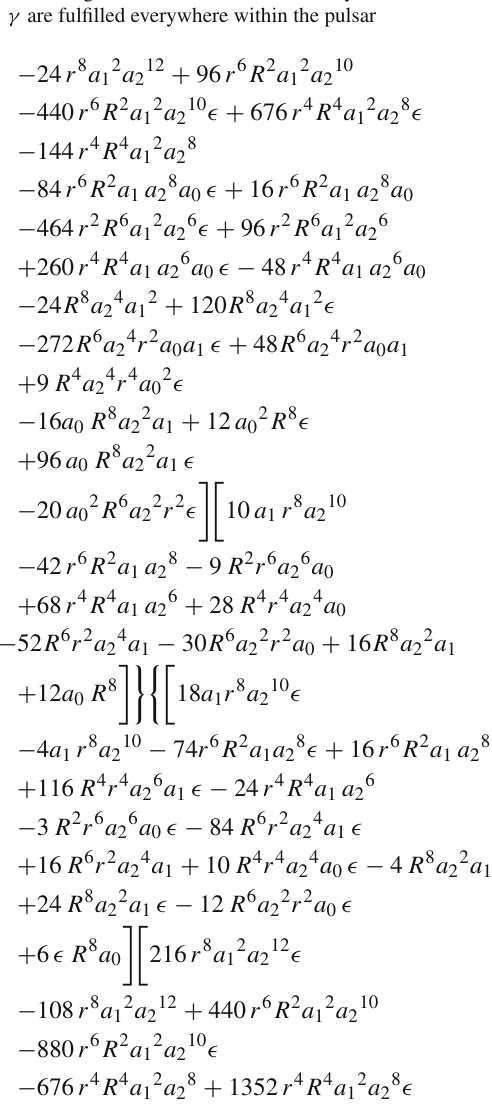
. The radial and tangential adiabatic 3